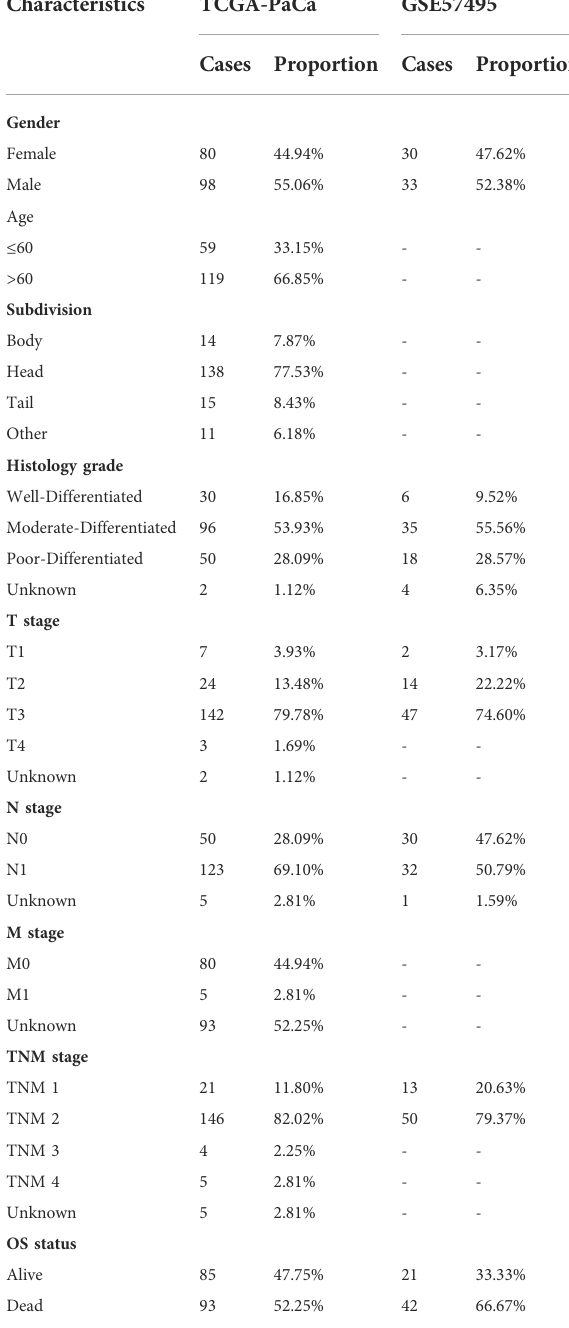
TABLE 1 Baseline characteristics of PaCa patients from the TCGA and GSE57495 datasets.